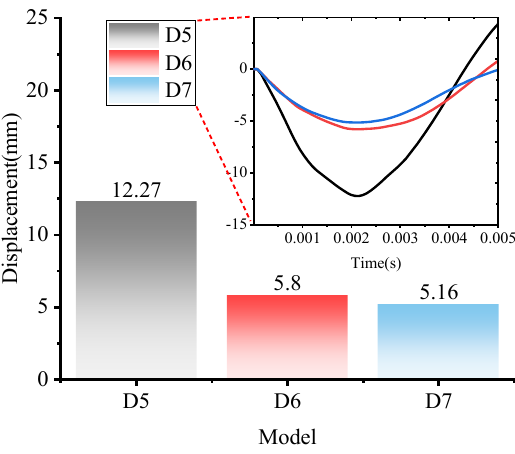
Figure 12. Displacement peaks of model D5, D6 and D7 and curves .